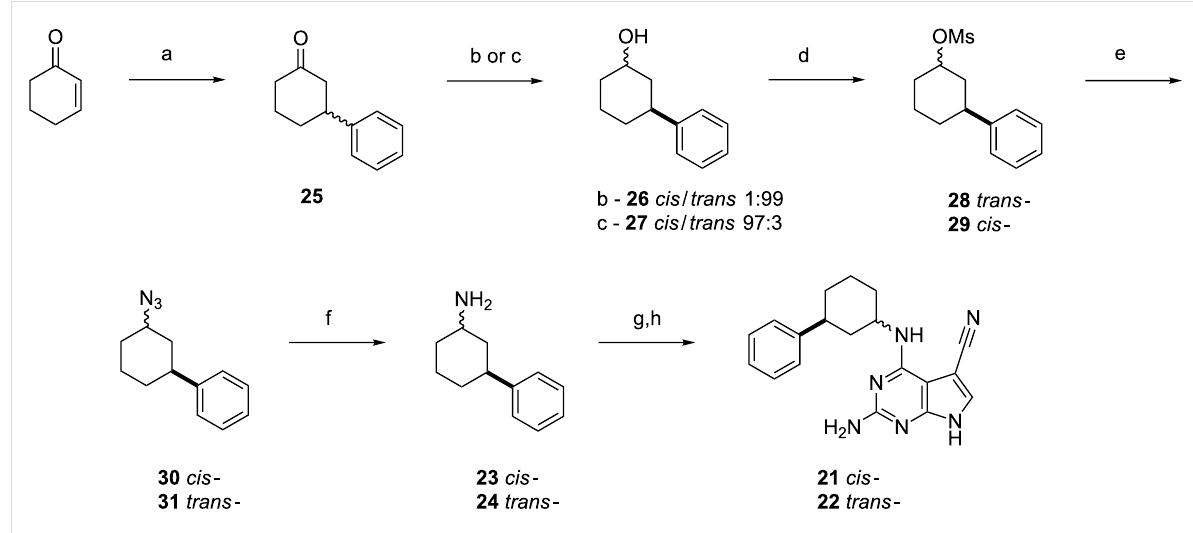
Figure 6: Synthesis of 21 and 22 , 3-arylcyclohexylamine derivatives of PreQ 0. Reagents and conditions: (a) PhB(OH) 2 , Pd(OAc) 2 , bpy, H 2 O/THF/ AcOH, 3 days, 60 °C, 98%; (b) K-Selectride, THF, 2 h, − 90 °C; then KOH (aq), H 2 O 2 , 30 min, rt, 80%, 99% ds; (c) LiAlH 4 , Et 2 O, 1,5 h, 0 °C to rt; then NaOH (aq), 30 min, rt, 76%, 97% ds (d) MsCl, Et 3 N, THF, 16 h, rt, ( trans - 67%, cis - 64%); (d) NaN 3 , DMF, 2 days, 80 °C, ( trans - 56%, cis - 67%); (f) HCO 2 NH 4 , Pd/C, MeOH, 1.5 h, reflux, ( trans - 92%, cis - 94%); (g) 9 , Et 3 N, n -BuOH, 16 h, 130 °C; (h) KOH, n -BuOH/EtOH, 16 h, 80 °C, ( trans - 38%, cis -